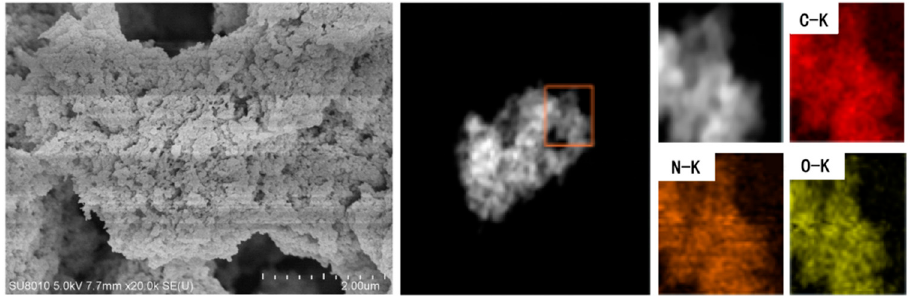
Figure 7. SEM, TEM, and EDS-mapping of TpPa − (SO 3 H–Py).